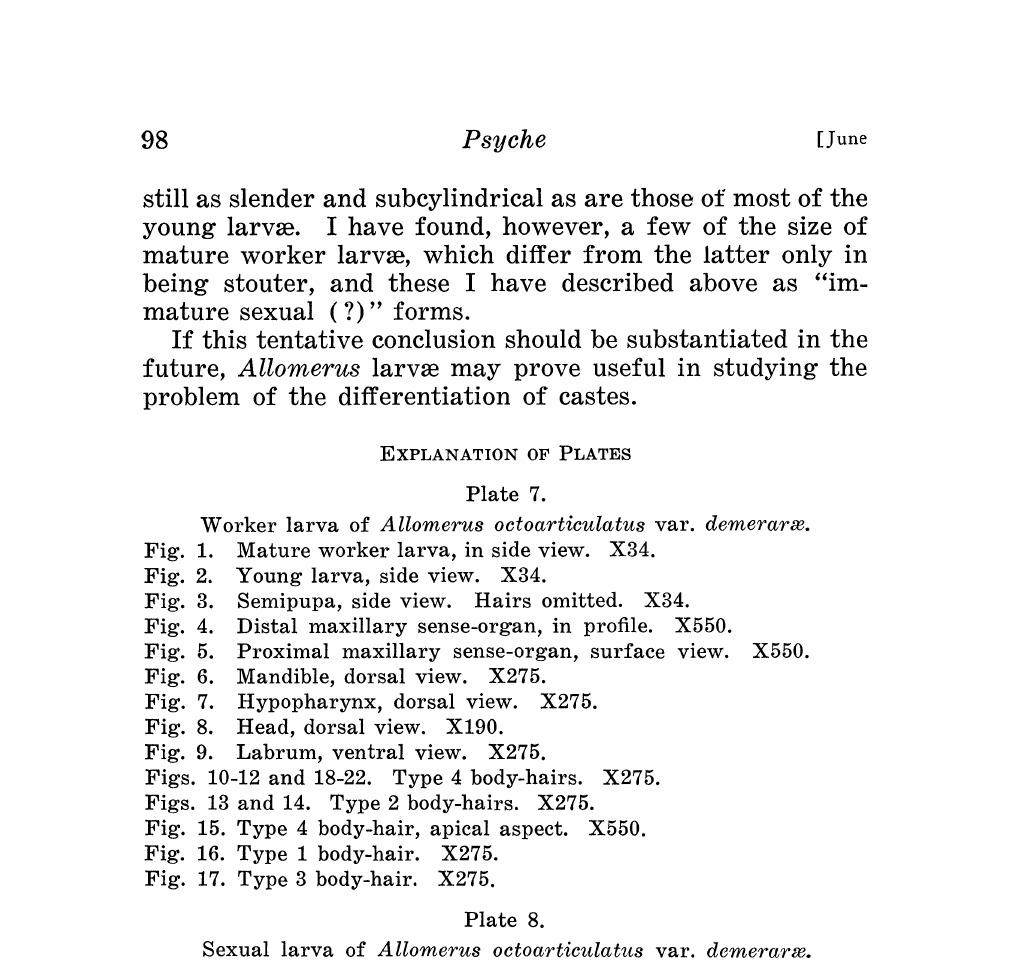
Fig. Fig. 9. Labrum, ventral view. X275. Figs. 10-12 and 18-22. Type 4 body-hairs. X275. Figs. 13 and 14. Type 2 body-hairs. X275. Fig. 15. Type 4 body-hair, apical aspect. X550. Fig. 16. Type 1 body-hair. X275. Fig. 17. Type 3 body-hair. X275. Plate 8. Sexual larva of Allomerus octoarticulatus var. demerarx. Type III body-hair. X275. Fig. 1. Type II body-hair. X275. Type IV body-hair. X275. Fig. 3. Young (half-grown?) sexual larva, side view. X34. Fig. 4. Type I body-hair. X275. Fig. 5. Young sexual larva before molting to definitive sexual Fig. 6. form, side view X34. Mature sexual larva (A) compared in size with mature Fig. 7. worker larva (B), side view. Outlines only.